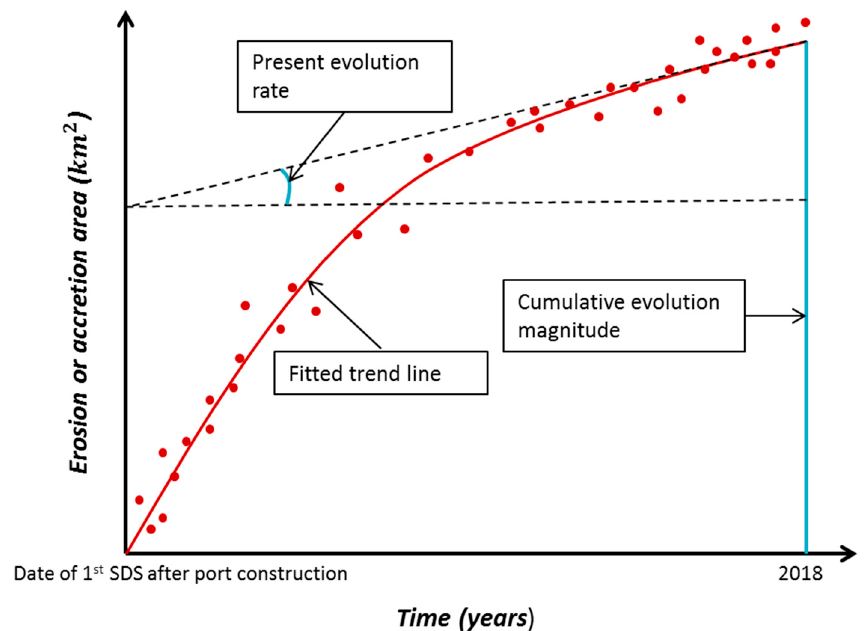
Figure 5. Schematic illustration of the fitting of the exponential trend line to the Satellite Derived Shoreline (SDS) data over the study period. Trend lines are fitted separately for the gross accretion and erosion areas. The historic beach evolution is determined from the cumulative beach area change between the first and last available SDS. The present beach evolution rate is estimated from the derivative of the SDS on 1 January 2018.